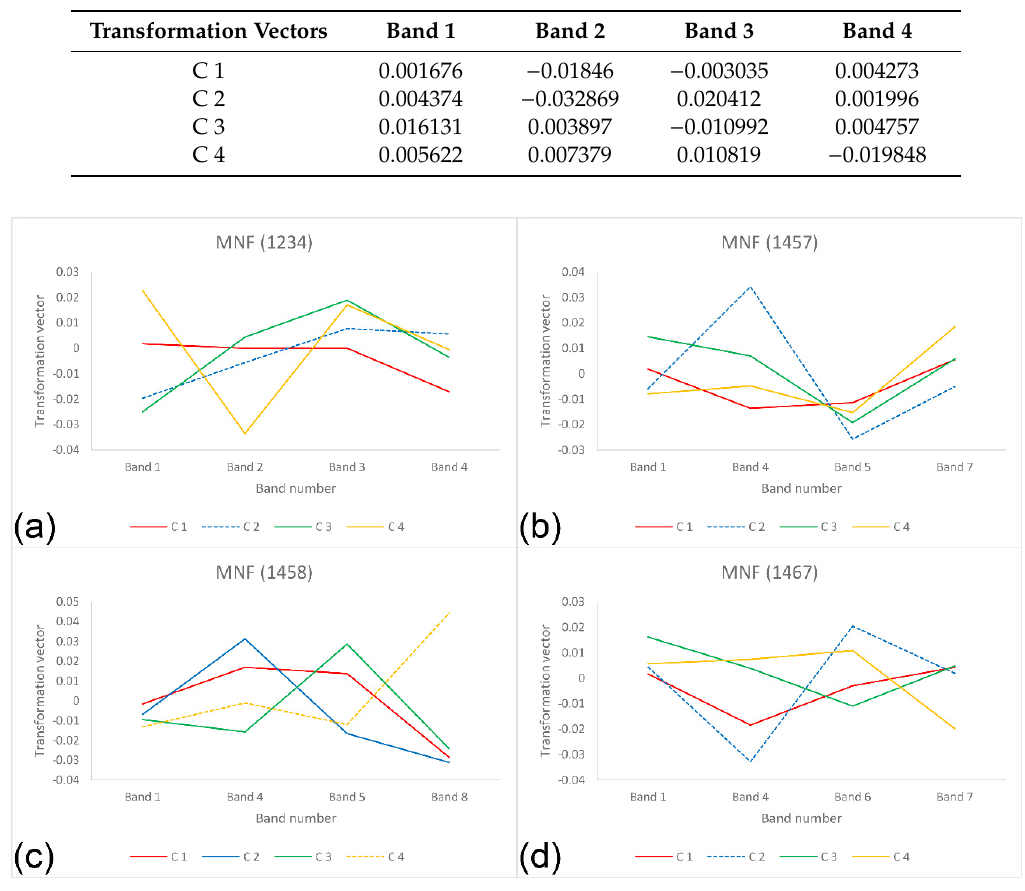
Figure 9. Trends of transformation vectors related to the selective MNF analysis on the ASTER spectral bands presented in Tables 5–8, are shown in ( a – d ),